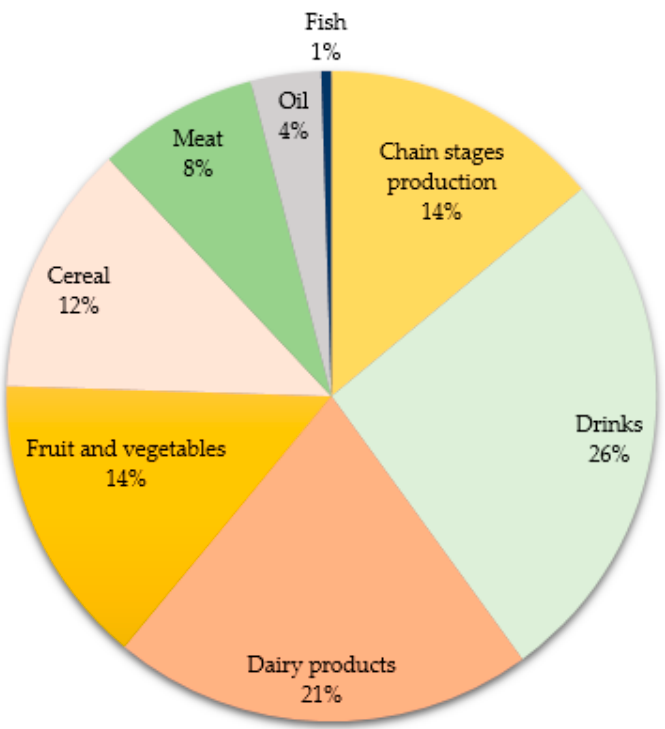
Figure 1. Production of agro-food waste in di ff erent industries